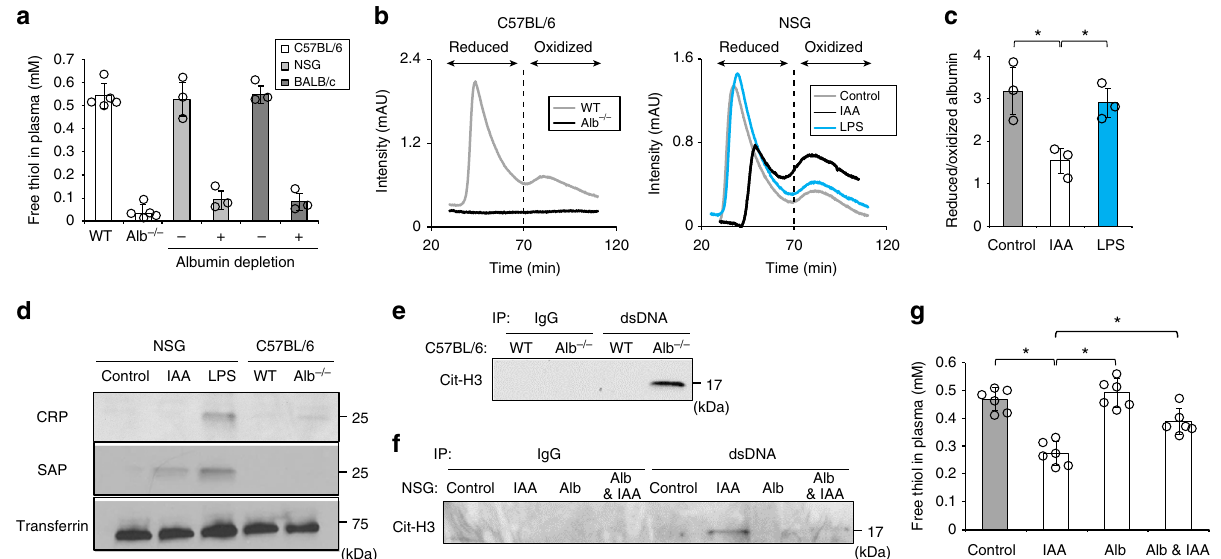
Fig. 2 Plasma redox imbalance induces NETosis. a Concentration of free thiol in plasma from wild-type (WT) vs. albumin de fi cient (Alb − / − ) C57BL/6 mice and control vs. albumin-depleted plasma from NOD scid gamma (NSG) and BALB/c mice. b – d Plasma isolated from the blood of WT and Alb − / − C57BL/6 mice and NSG mice 2 days post saline, IAA (30 mg/kg), or LPS (8 mg/kg) injection was subjected to FPLC ( b , c ) and Western blotting ( d ). b Representative FPLC results for the redox state of albumin in C57BL/6 (left) and NSG (right) mice. c The ratio of peak intensity for reduced/oxidized albumin in NSG mice. d Western blotting with an antibody against C-reactive protein (CRP) and serum amyloid P component (SAP). e – g Plasma was isolated from the blood of WT and Alb − / − C57BL/6 mice and NSG mice 2 days post saline or IAA (30 mg/kg) injection following intravenous injection of PBS or murine albumin (20 mg/mouse). e , f Immunoprecipitation of cell-free DNA in the plasma from C57BL/6 ( e ) and NSG ( f ) mice using an anti-dsDNA antibody followed by Western blotting using an antibody against citrullinated histone H3 (Cit-H3). g Plasma free thiol concentration. a , c , g Results represent individual values with the mean ± s.d. ( n = 3 – 6; biological replicates, * P < 0.05 by Dunnett ’ s